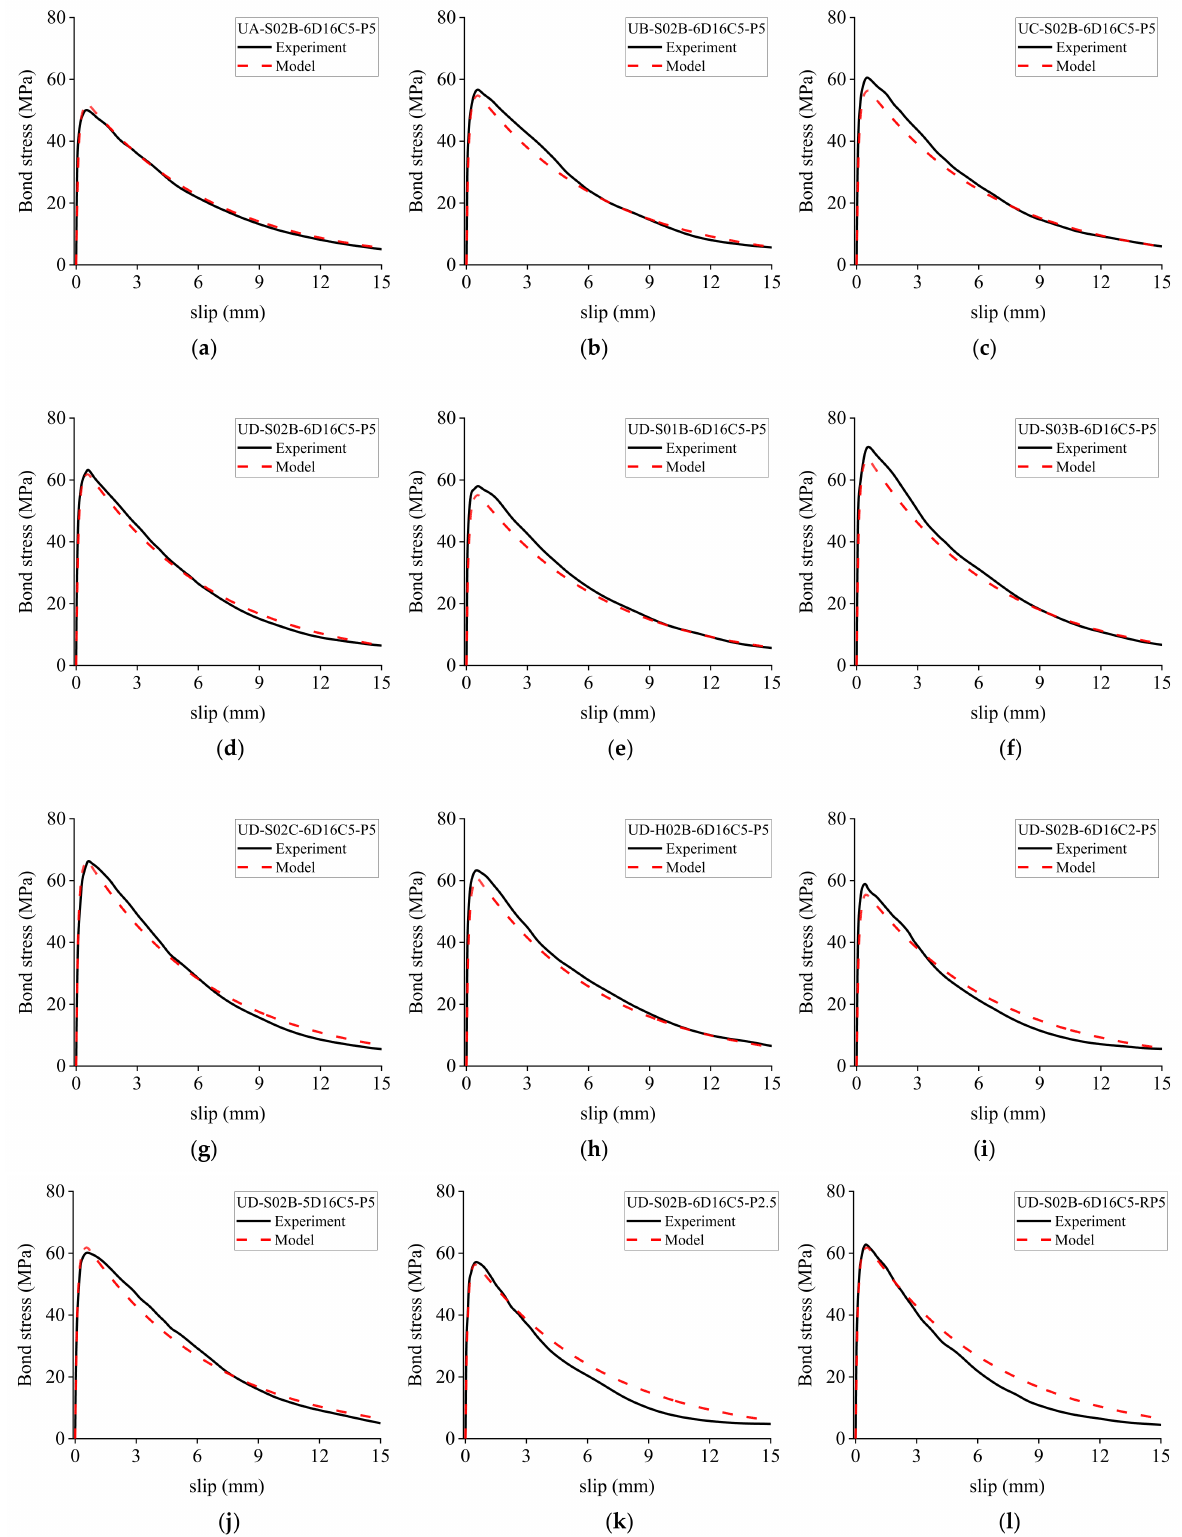
Figure 17. Comparison of the model predictions with the tested bond-slip curves: ( a ) UA-S02B- 6D16C5-P5; ( b ) UB-S02B-6D16C5-P5; ( c ) UC-S02B-6D16C5-P5; ( d ) UD-S02B-6D16C5-P5; ( e ) UD- S01B-6D16C5-P5; ( f ) UD-S03B-6D16C5-P5; ( g ) UD-S02C-6D16C5-P5; ( h ) UD-H02B-6D16C5-P5; ( i ) UD-S02B-6D16C2-P5; ( j ) UD-S02B-5D16C5-P5; ( k ) UD-S02B-6D16C5-P2.5; ( l )